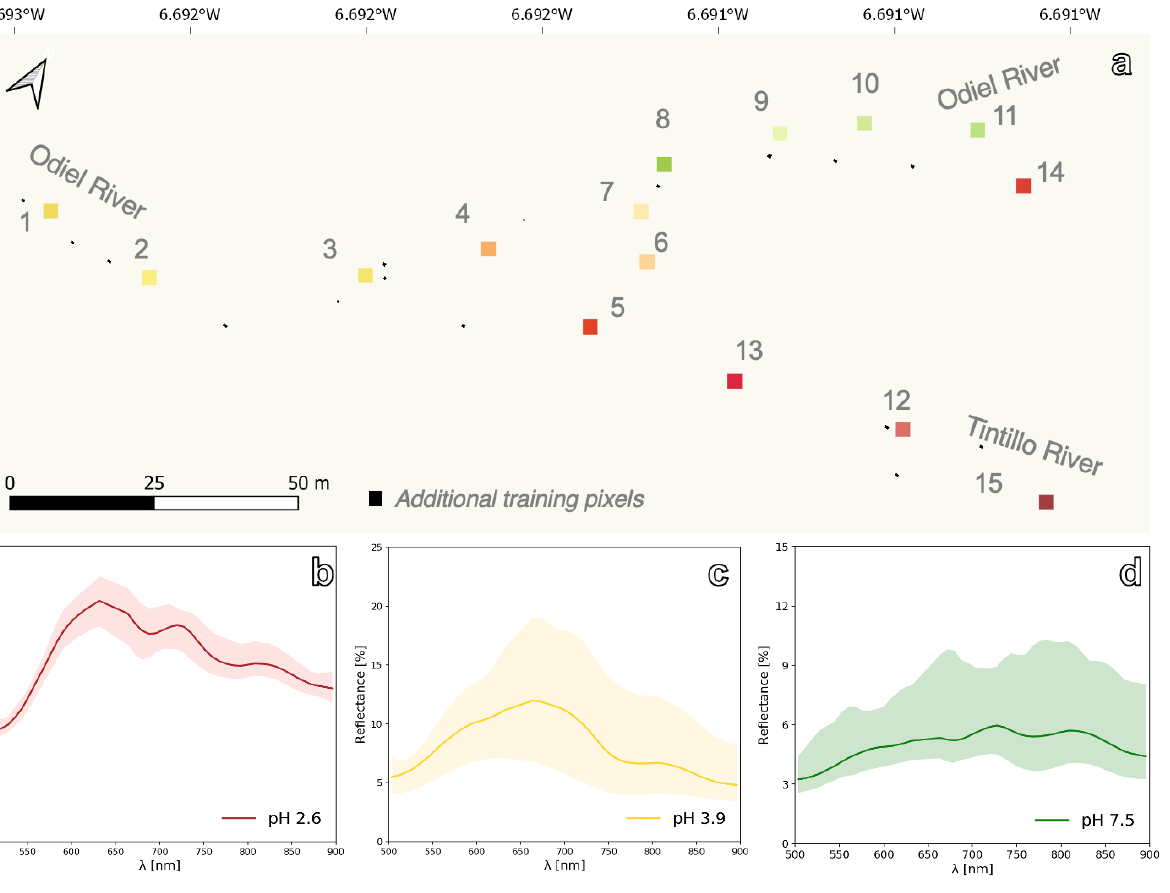
Figure 6. ( a ) Created training dataset based on 15 ground-truth georeferenced stations. Mean spectrum of the clustered pixels used in the training dataset and standard deviation plotted as shaded envelope. ( b ) pH 2.6 ( σ = 0.16), ( c ) pH 3.9 ( σ = 2.01), and ( d ) pH 7.5 ( σ =